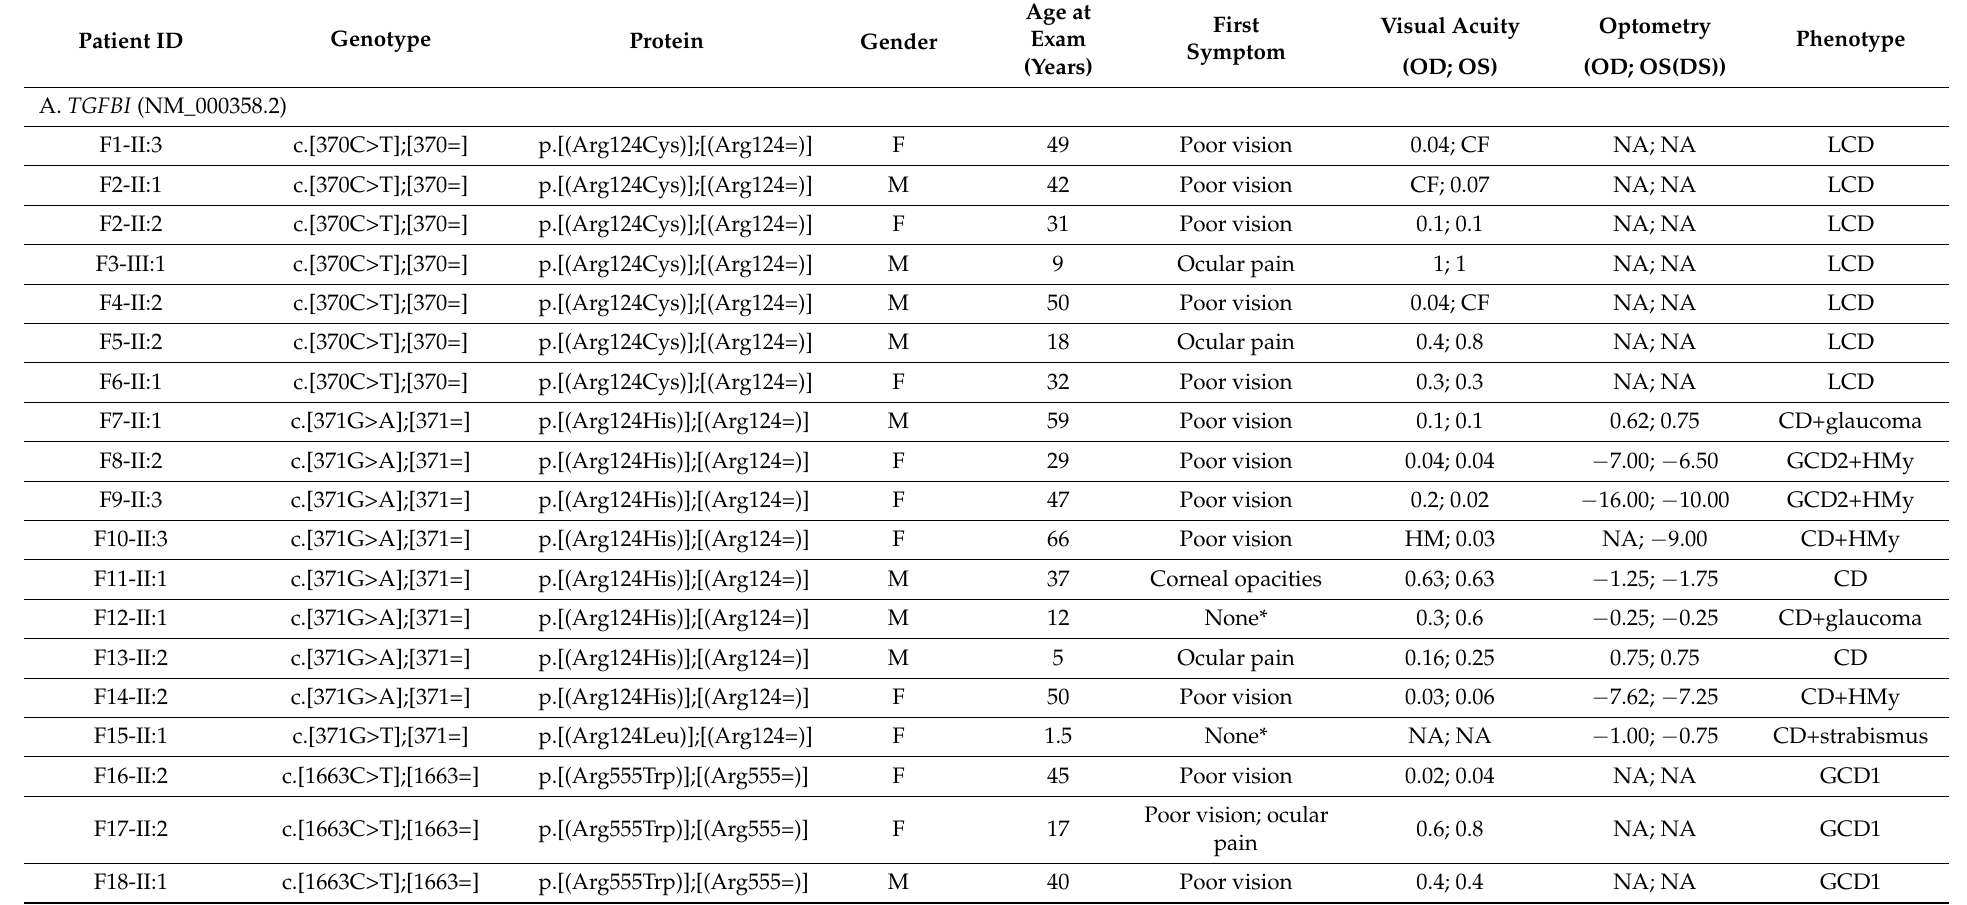
Table 2. Clinical information of patients with pathogenic or likely pathogenic variants in TGFBI , CHST6 , SLC4A11 , or ZEB1